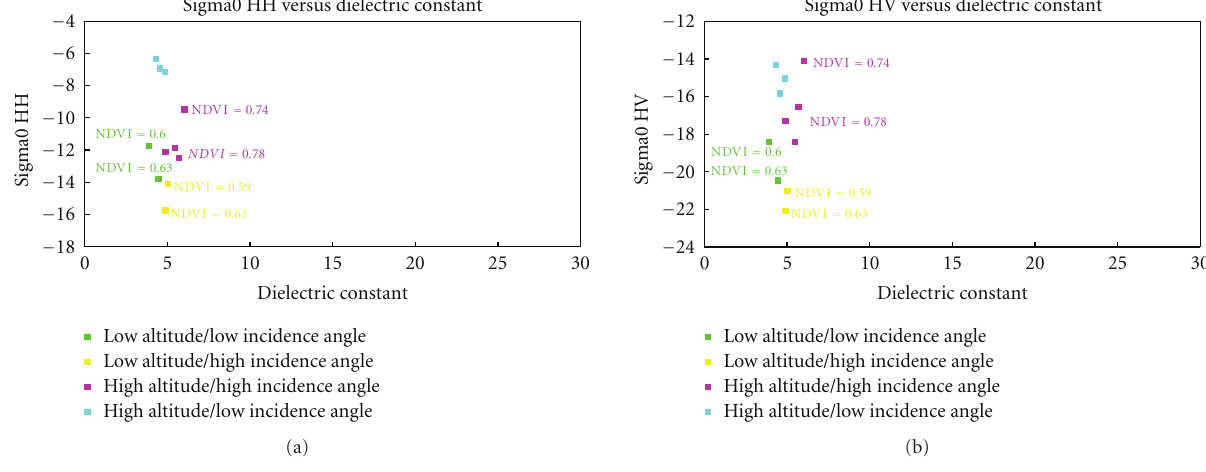
Figure 5: Scatter plots of backscattering coe ffi cients extracted from the RADARSAT2 images versus dielectric constant measurements over pasture areas and with dielectric constantvalues between 4.5and 5.5 in the case of (a)HH polarizationconfigurationand (b) HV polarization configuration. NDVI values are shown for the samples which show strong residual variability in the backscattering coe ffi cient